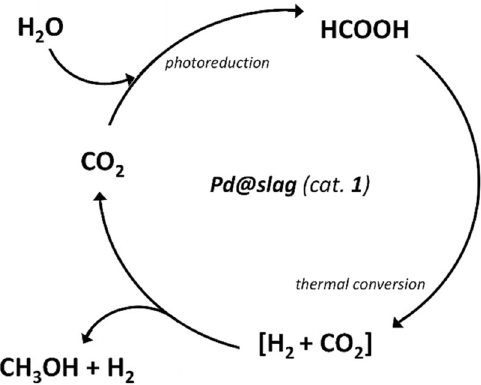
Scheme 2. Schematic representation of overall process.